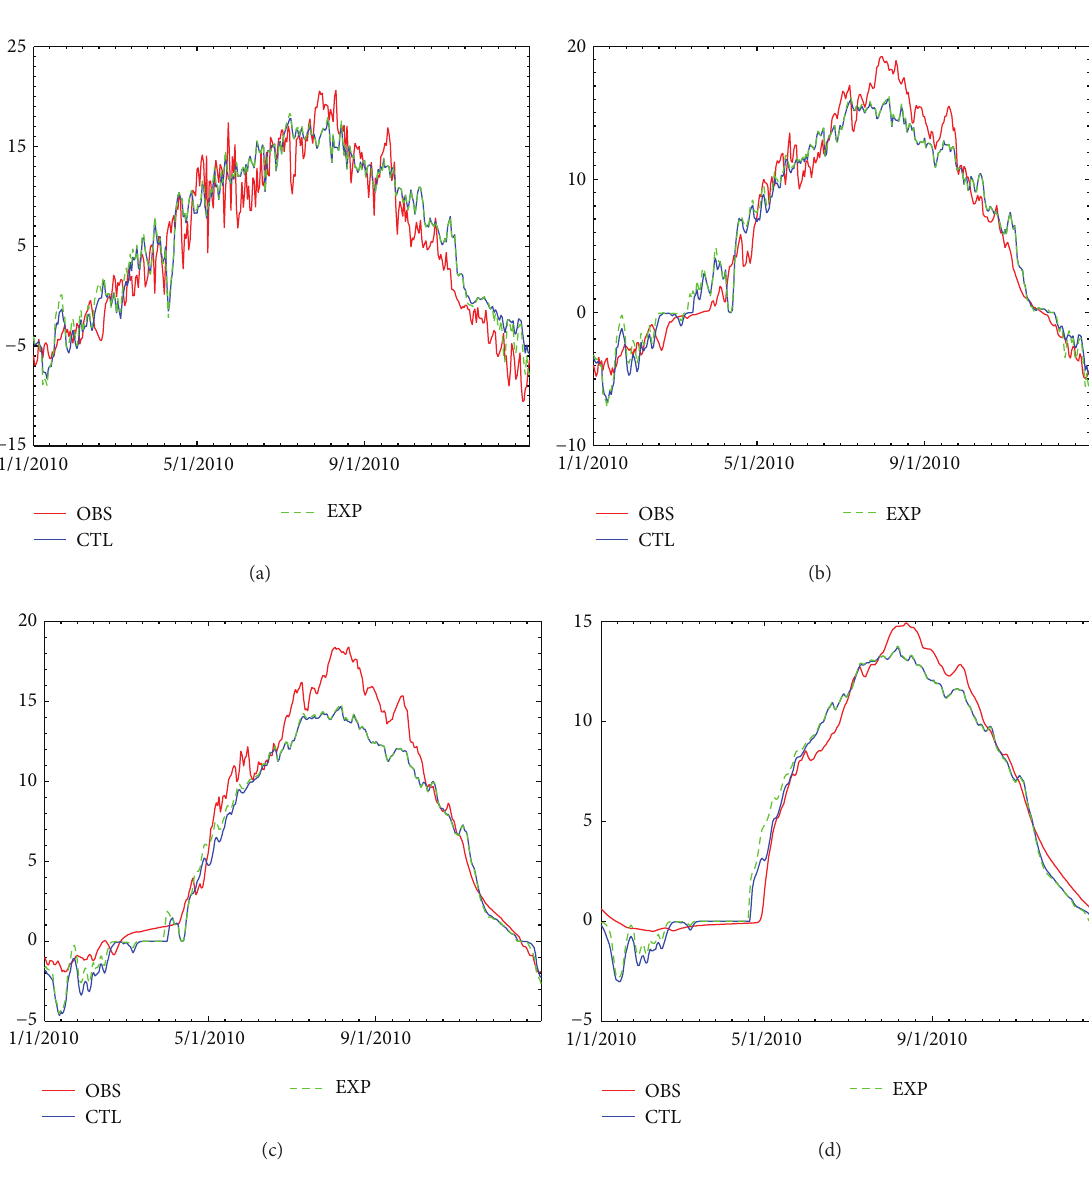
Figure 7: Daily average soil temperature ( ∘ C) at (a) 5 cm, (b) 20 cm, (c) 40cm, and (d) 80 cm at ZS